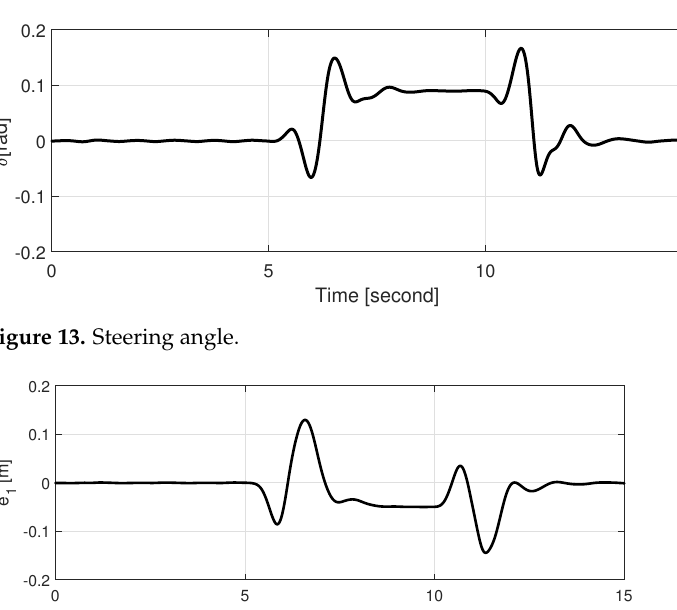
Figure 12. Curved Road.